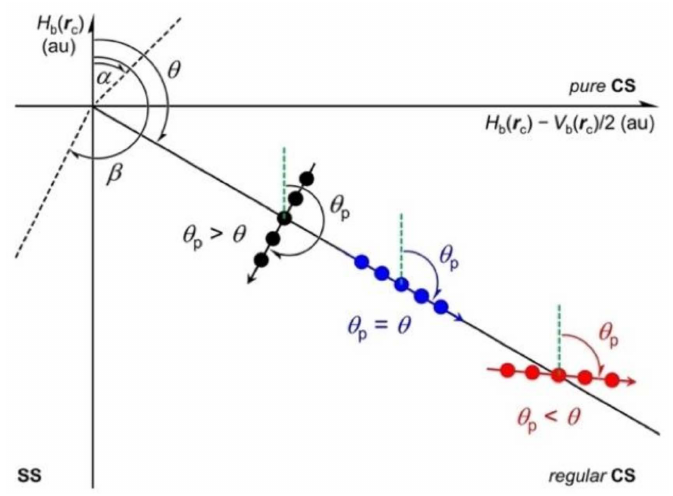
Figure 8. QTAIM-DFA plots of H b ( r c ) versus H b ( r c ) − V b ( r c )/2 for normal ( θ p > θ ) and inverse ( θ p < θ ) dynamic behavior, denoted by black and red dots, respectively, together with the border for blue dots ( θ p = θ ). The limited values α (= 45.0 ◦ ) < θ < β (= 206.6 ◦ ) are also